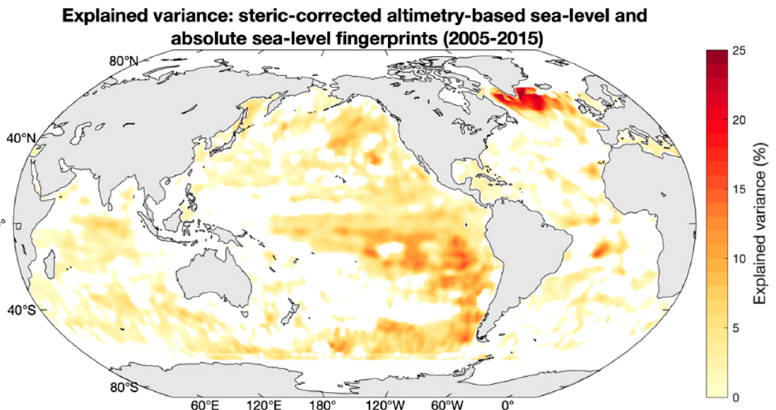
Figure 6. Explained variance map between steric-corrected altimetry and modelled absolute sea-level fingerprints time series for January 2005–December 2015.